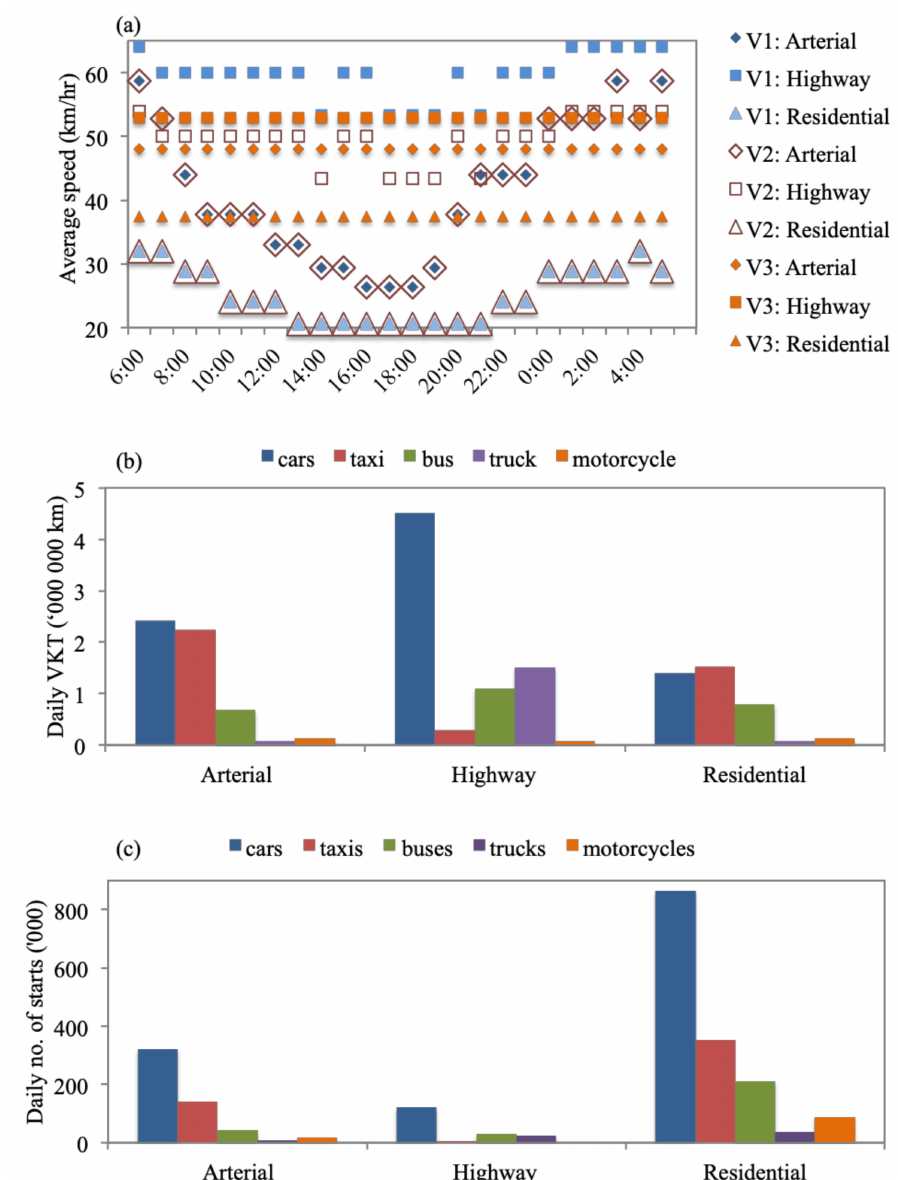
Figure 1. ( a ) Hourly average speed in Greater Cairo where V1 indicates cars and taxis, V2 is buses and trucks, and V3 is motorcycles where each group is considered to have similar driving speeds [59]. ( b ) Daily VKT (distance traveled in km) by each vehicle type across the three studied road types [27,55,56]. ( c ) Daily number of ‘starts’ by each vehicle type across the three studied road types